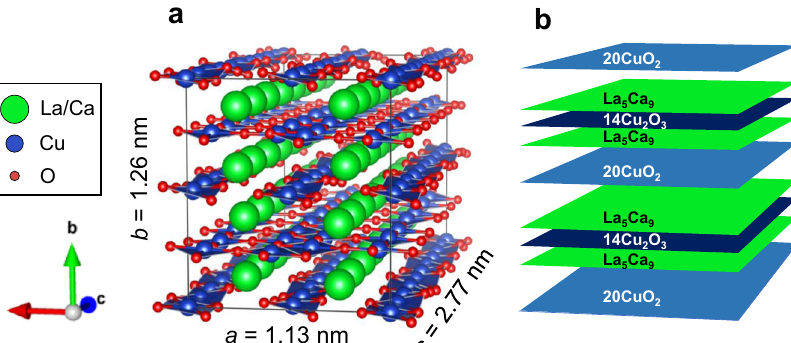
Fig. 1 Layer structure of La 5 Ca 9 Cu 24 O 41 . a A unit cell of the spin-chain – spin-ladder cuprate La 5 Ca 9 Cu 24 O 41 . The crystal structure is drawn via VESTA 40 and referring to the structural data 41 . b A schematic illustration of the layer structure for Fig. 1a consisting of two kinds of subsystems, CuO 2 and (La 5/14 Ca 9/14 ) 2 Cu 2 O 3 .